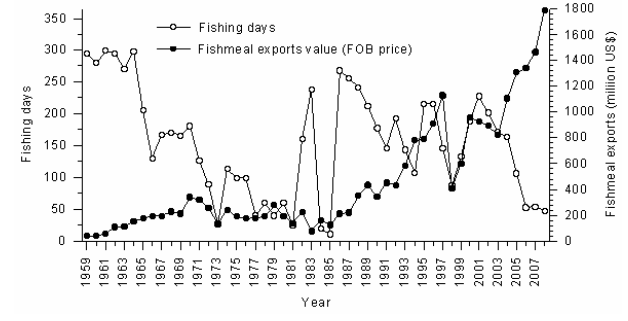
Fig. 3 . Annual number of anchovy fishing days and value of Peruvian fishmeal exports,